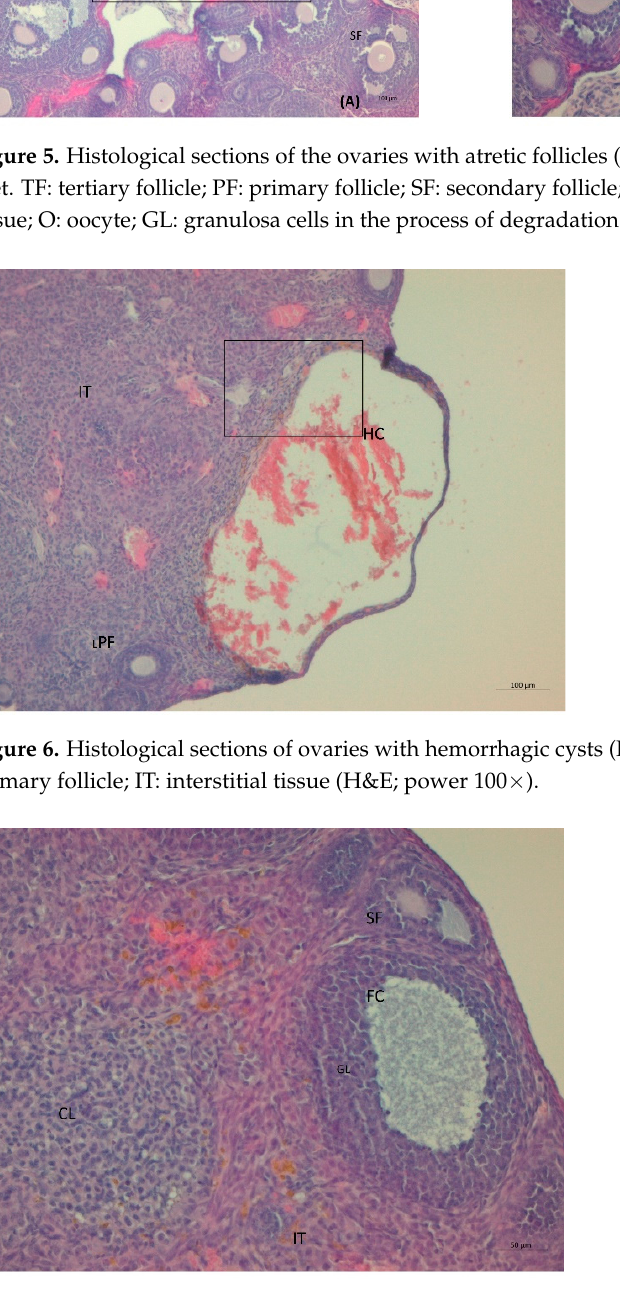
Figure 8. Histological sections of ovaries with follicular cysts (FC) in LET-treated mice on the HF/HFr diet. TF: tertiary follicle; O: oocyte; GL: irregular granulosa layer; CO: cumulus oophorus; A: antrium; LPF: late primary follicle; SF: secondary follicle; ZP: zona pellucida; IT: interstitial tissue (H&E; power 100×).